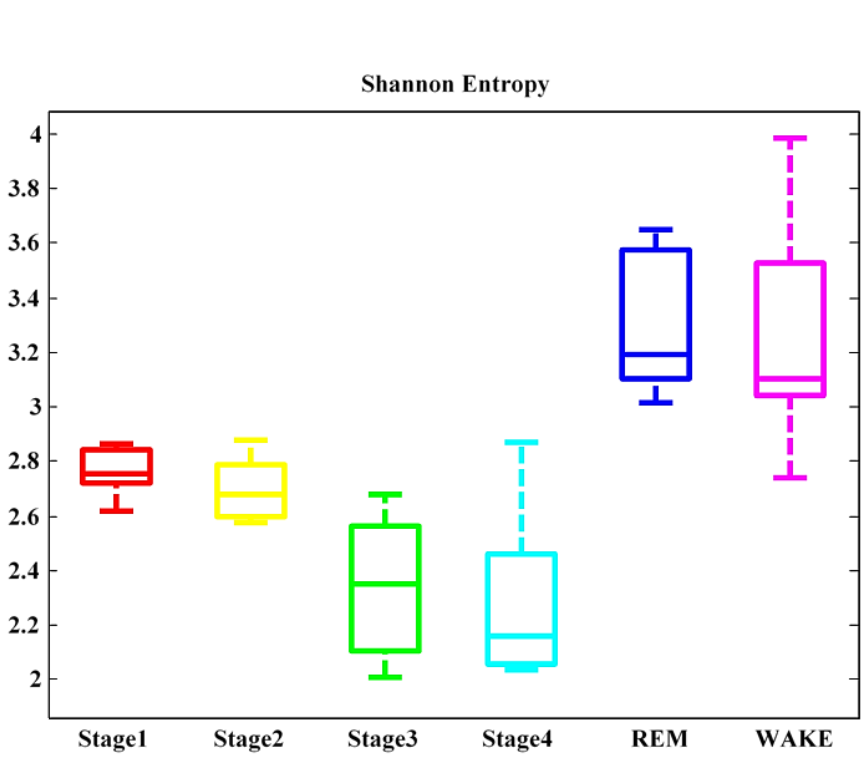
Fig. 8. Compare the sleep stages in DET.